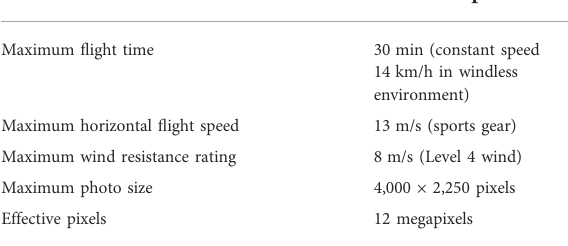
TABLE 1 The major parameters of MAVIC